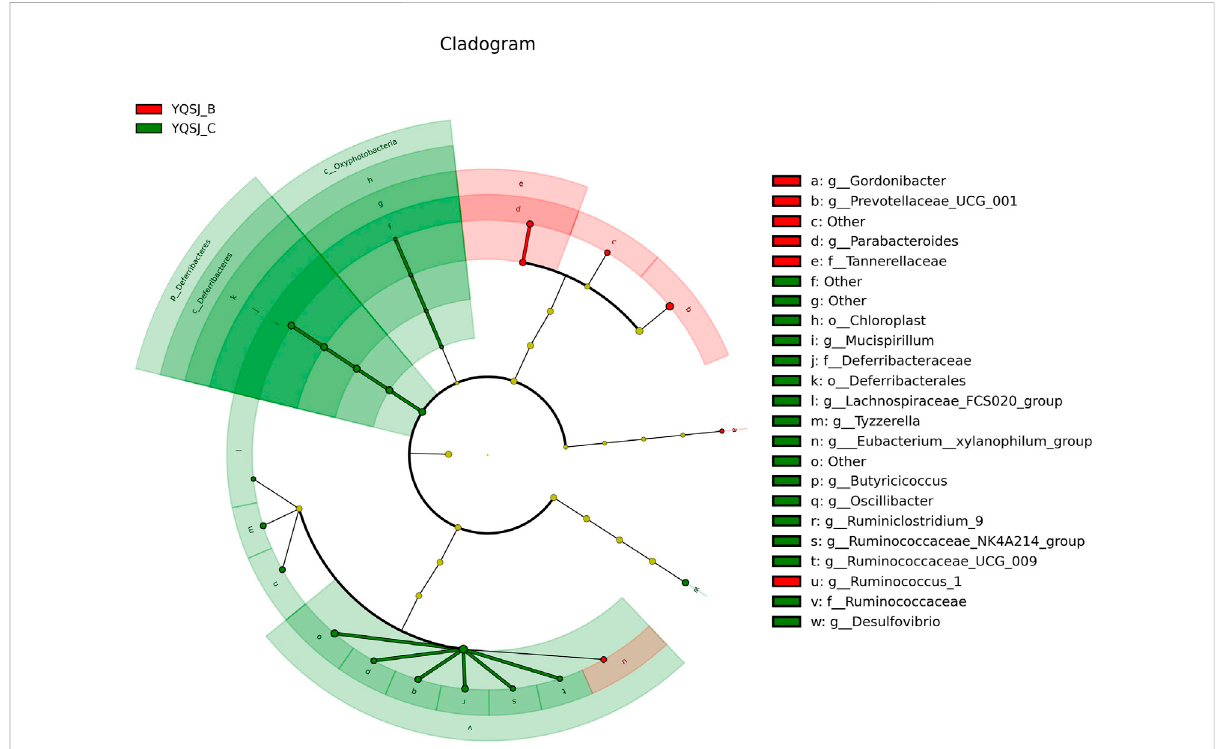
FIGURE 5 The cladogram in LEfSe analysis of bacterial community structure in YQSJ group. The branch chart displayed the differences in the fecal taxa. The red and green node represented the microbial group playing an important role in the red and greengroup, respectively. The red color (YQSJ_B) indicated that the mouse fecal samples were collected before treatment at day 27 – 28 in YQSJ group, while the green color (YQSJ_C) represented the mouse fecal samples were collected after treatment at day 66 – 67 (the end point) group. The “ other ” represented the fl ora that was not classi fi